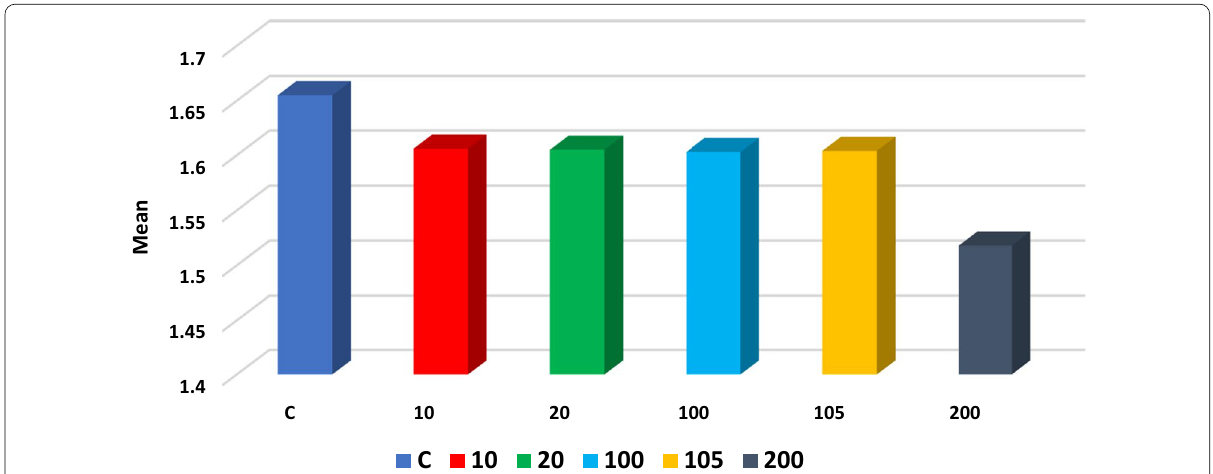
Fig. 11 Comparison between viability of OEC cultured in different concentrations of apricot oil